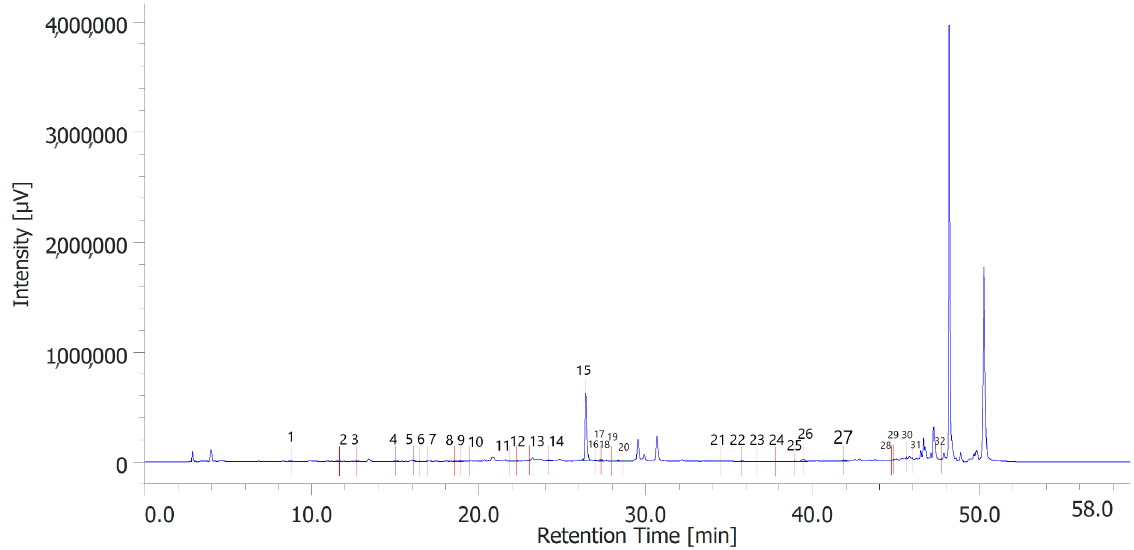
Figure 2. Phenolic compounds identified in the hydroalcoholic extract of hemp leaves. Among the compounds quantitatively determined, benzoic acid (peak #15) was the most prominent. The presence of significant amounts of benzoic acid in the extracts can also explain the observed antimicrobial properties against bacteria and